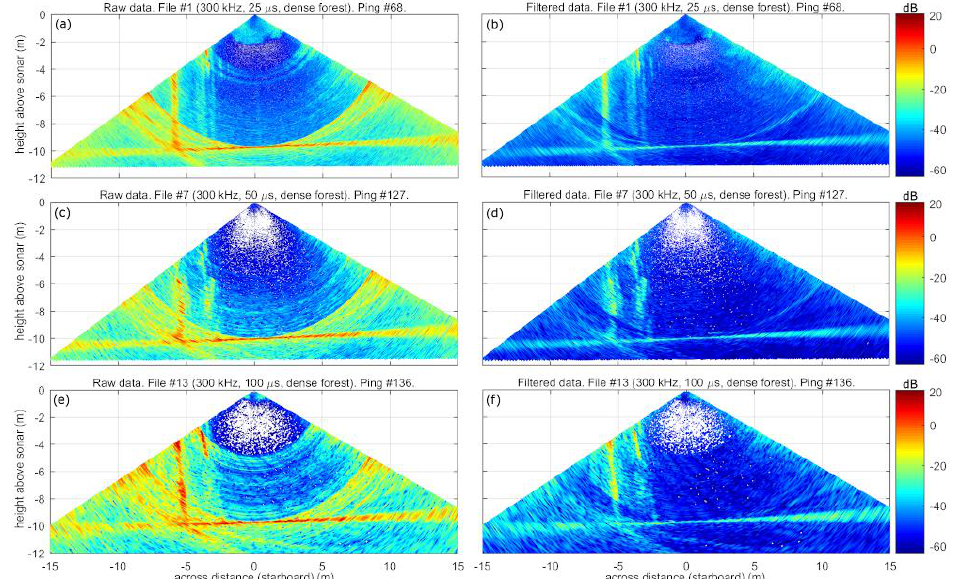
Figure 6. Illustration of EM 2040 C MBES water-column data acquired at 300 kHz over the dense forest patch before and after application of the SRSN filter, for different pulse length settings: ( a ) 25 μs pulse data example before filtering and ( b ) same ping after filtering, ( c ) 50 μs pulse data example before filtering and ( d ) same ping after filtering, ( e ) 100 μs pulse data example before filtering and ( f ) same ping after filtering. Data shown are for the ping corresponding to the shortest horizontal distance to the patch, in the first file acquired for each